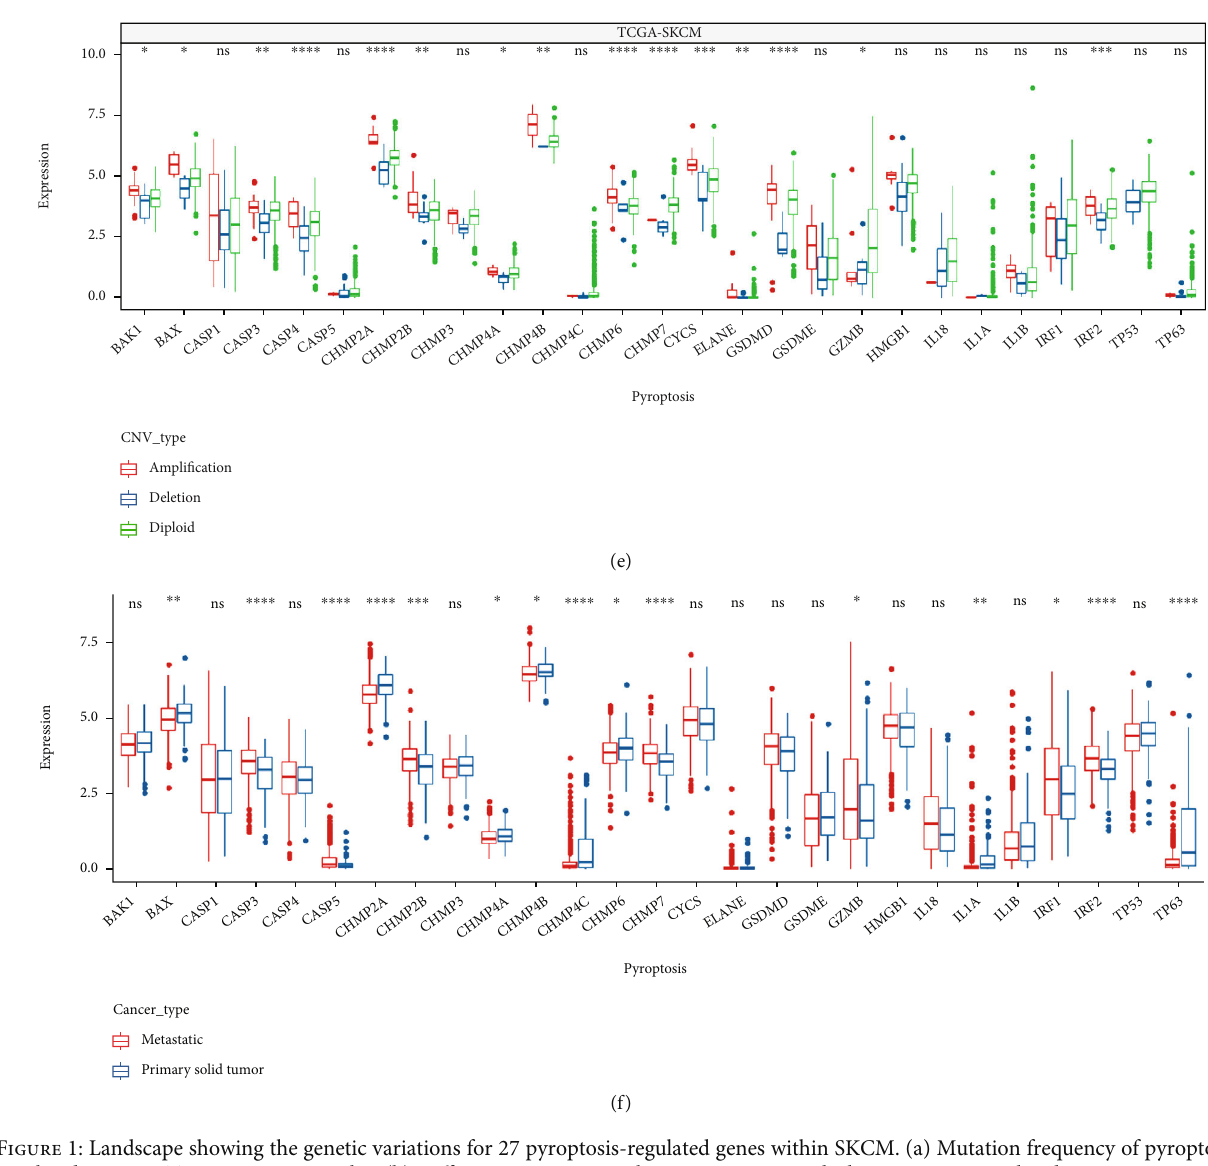
Figure 1: Landscape showing the genetic variations for 27 pyroptosis-regulated genes within SKCM. (a) Mutation frequency of pyroptosis- regulated genes in TCGA-SKCM samples. (b) Di ff erence in prognosis between patients with the pyroptosis-regulated gene mutations and wild-type (WT) patients. (c) Enriched pathways in pyroptosis-regulated gene mutations and WT patients. (d) CNV frequency of pyroptosis-regulated genes in TCGA-SKCM samples. (e) Pyroptosis-regulated genes harboring CNV ampli fi cation displayed high expression within SKCM. (f) The di ff erential expression in pyroptosis-regulated genes between metastatic and primary tumor